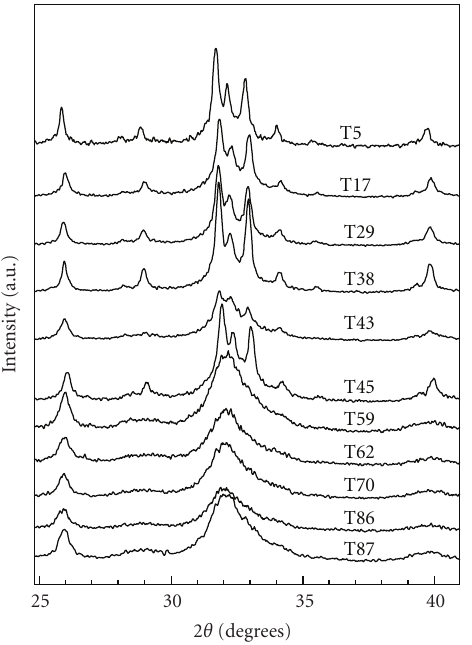
Figure 2: Parts of the XRD patterns displaying the development of the HAp phase in human dental apatite as a function of age.